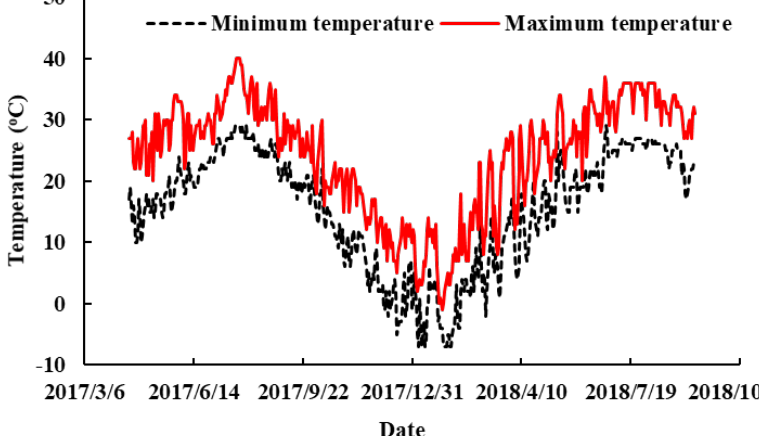
Figure 1. Daily maximum and minimum temperatures in the nurse during the experiment.